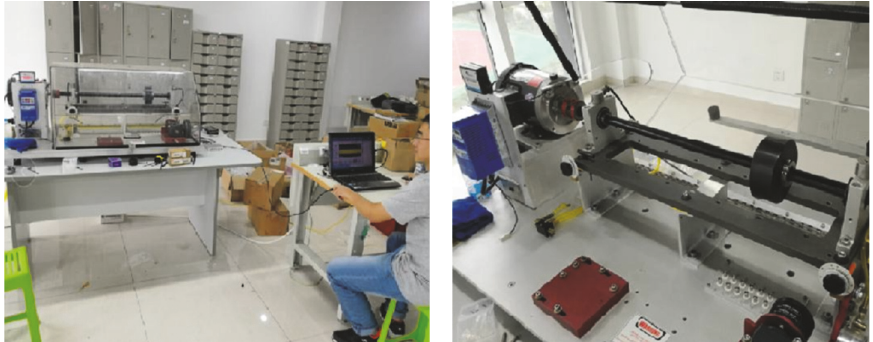
Figure 22: Experimental test rig 2.